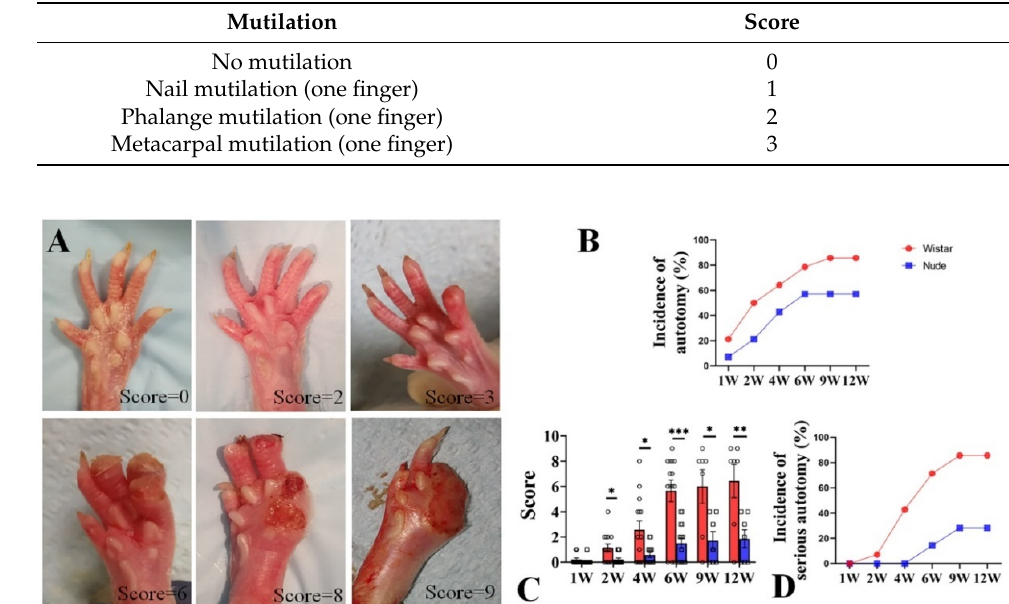
Table 1. The modified Wall’s Score.